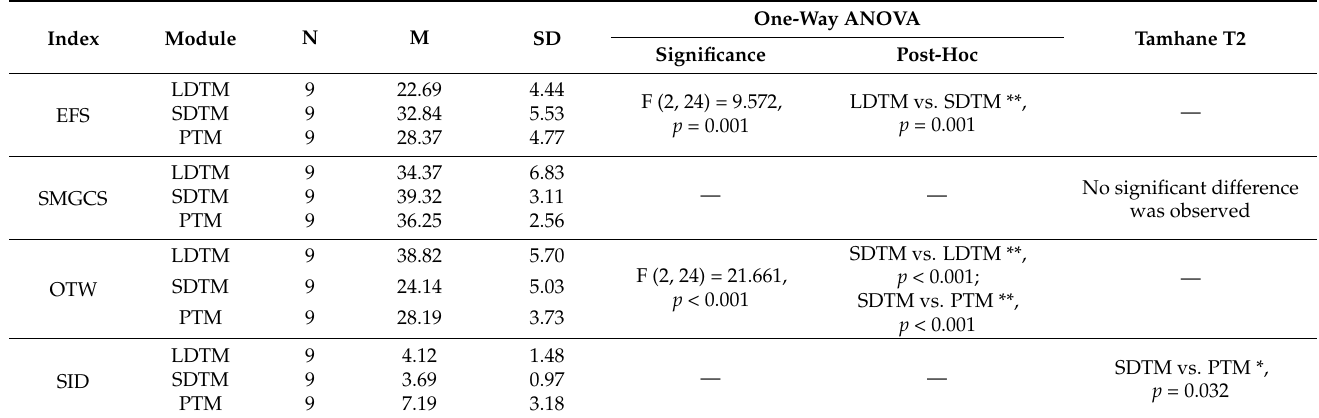
Table 2. The results and Comparisons of fixation count.